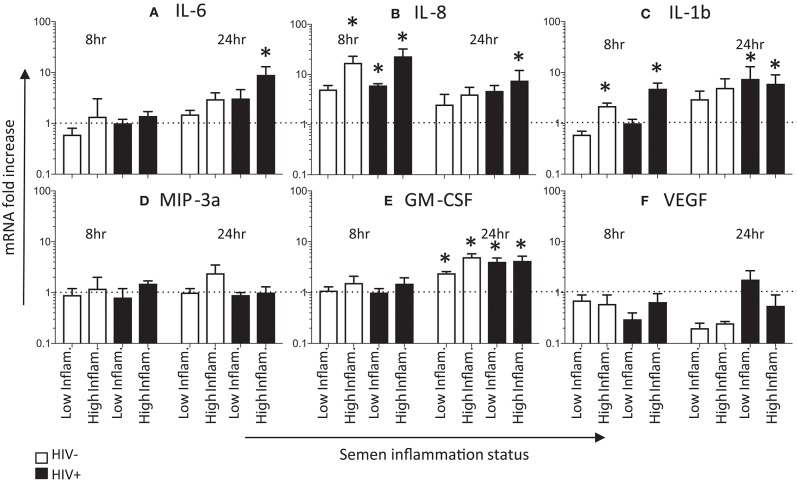
Effects of seminal plasma on cytokine mRNA expression by HeLa cells. Quantitative real-time PCR was used to determine the mRNA expression of (C) IL-6, (A) IL-8, (B) IL-1β, (E) GM-CSF, (D) MIP3α, and (F) VEGF by HeLa cells treated with 1:50 dilution of seminal plasma from HIV-negative (white bars) or HIV-positive individuals (black bars) for 8 h (n = 4) and 24 h (n = 3). The mRNA levels were normalized by housekeeping gene Human cyclophilin A. Data are represented as the mean ± SEM of duplicate wells in each experiment. Wilcoxon matched pairs (non-parametric) and standard matched pairs t-tests (parametric) were used to compare the control and treatment groups. *p < 0.05.